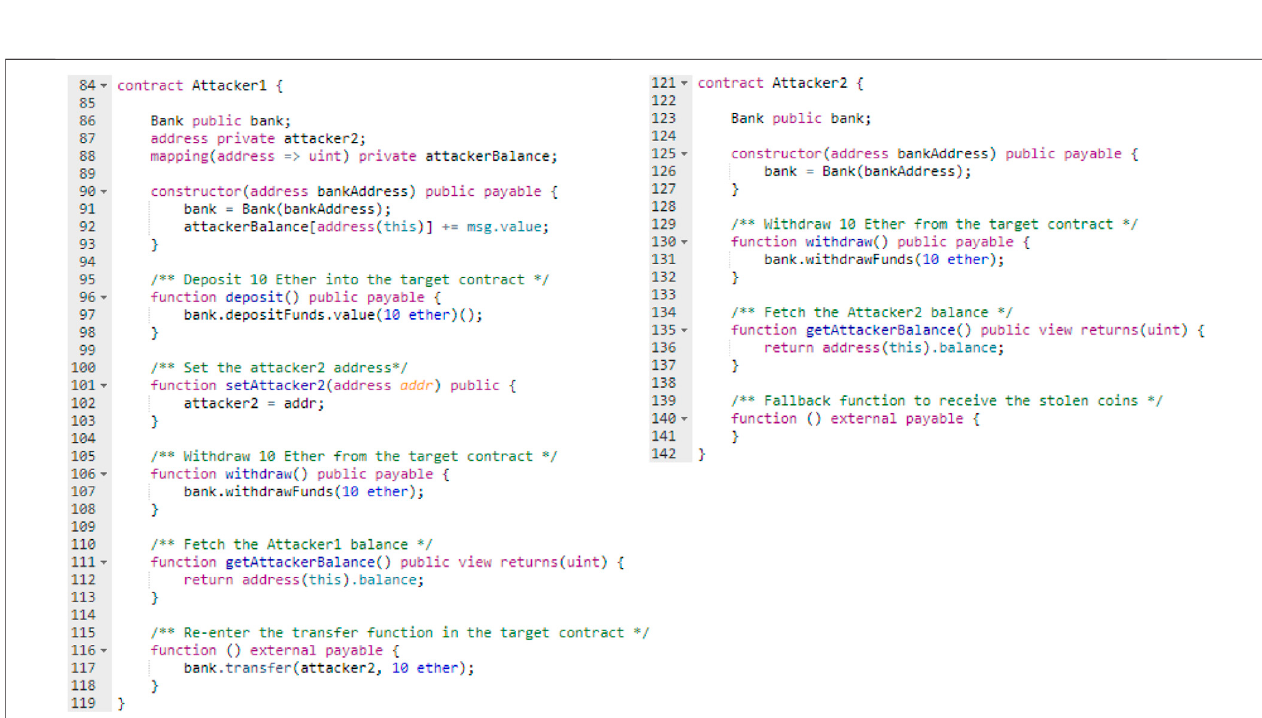
FIGURE 10 | The Attacker1{} and Attacker2{} contracts code.